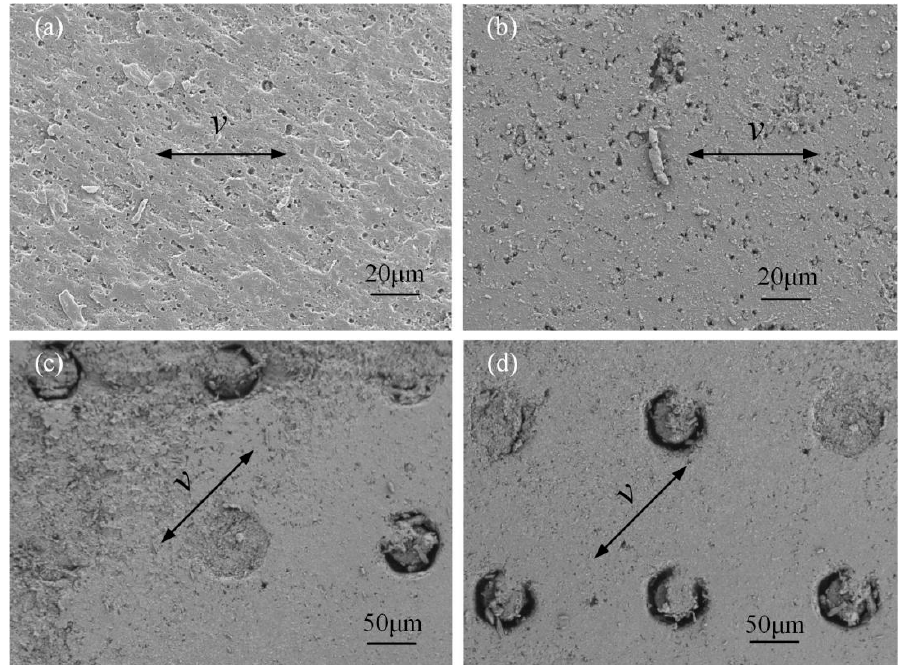
Figure 10. Surface topography of EPDM material after abrasion under conditions of ( a ) untextured, ( b ) single texture on GCr15 metal, ( c ) single texture on EPDM rubber, and ( d ) coupling texture parameters.